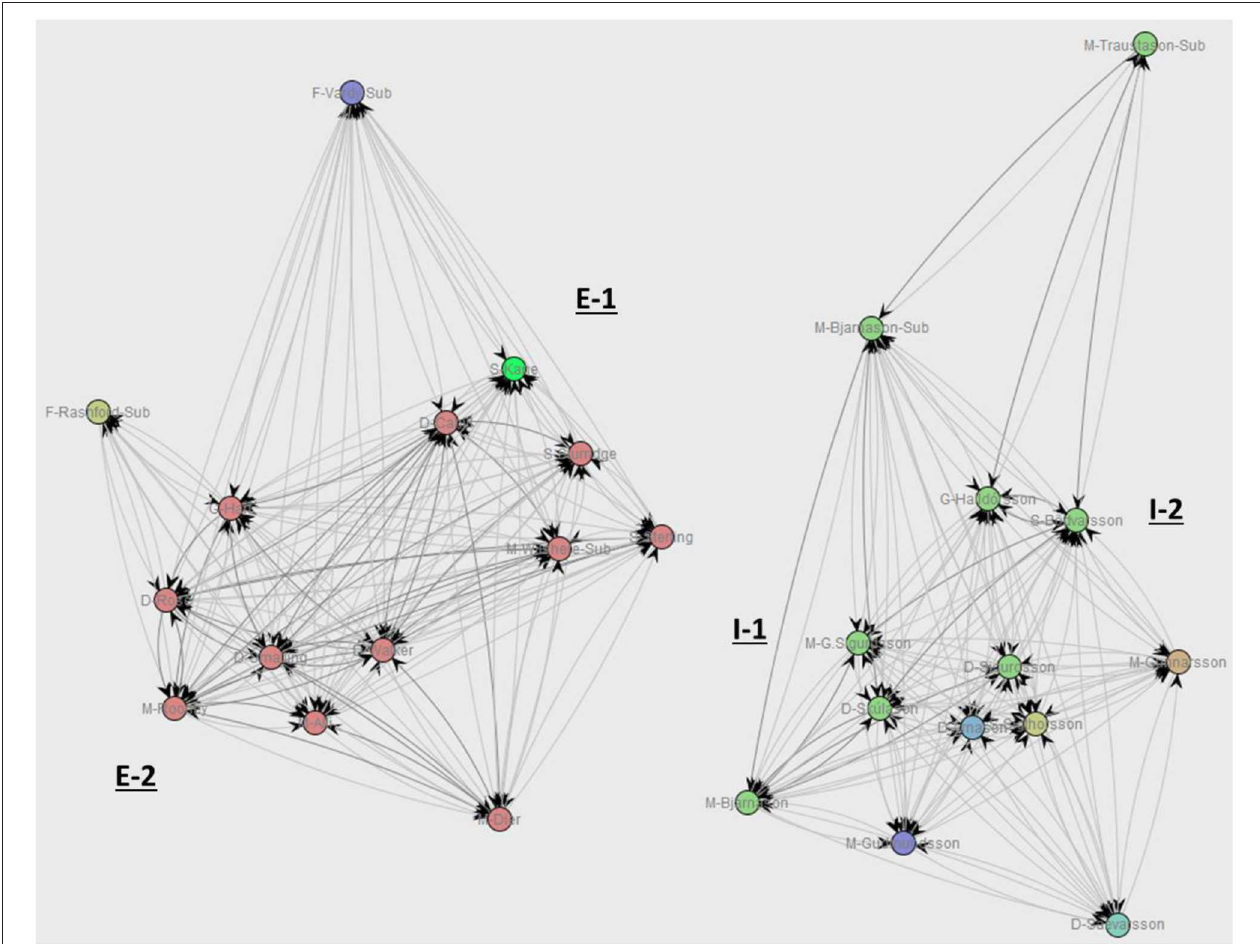
FIGURE 11 | Working Together comparison between England (Left) and Iceland (Right)